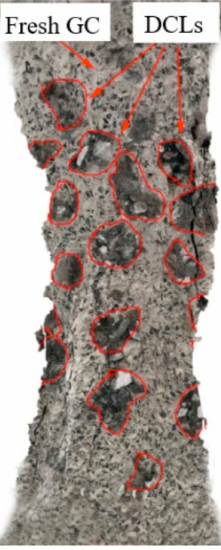
Figure 5. Failure pattern in specimen